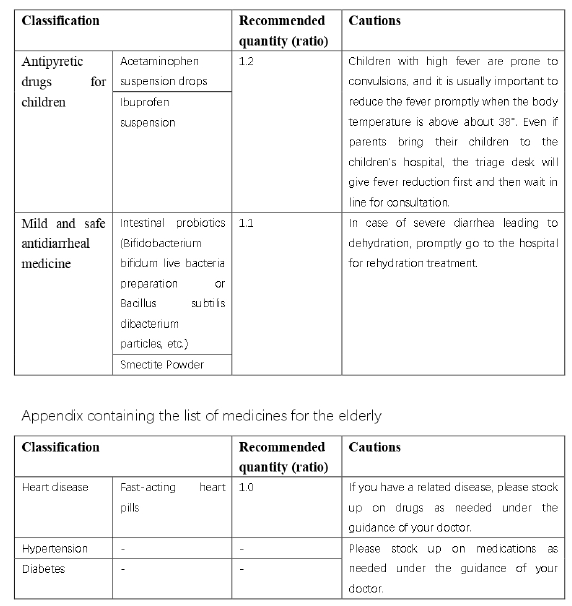
Figure 14. The initial version of the system.